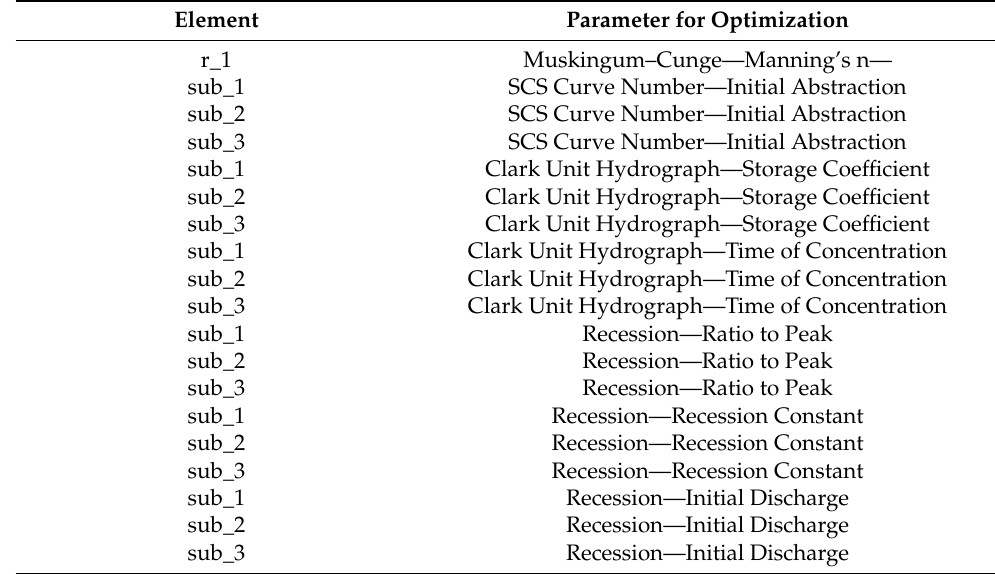
Table 6. The parameters for the HEC-HMS model